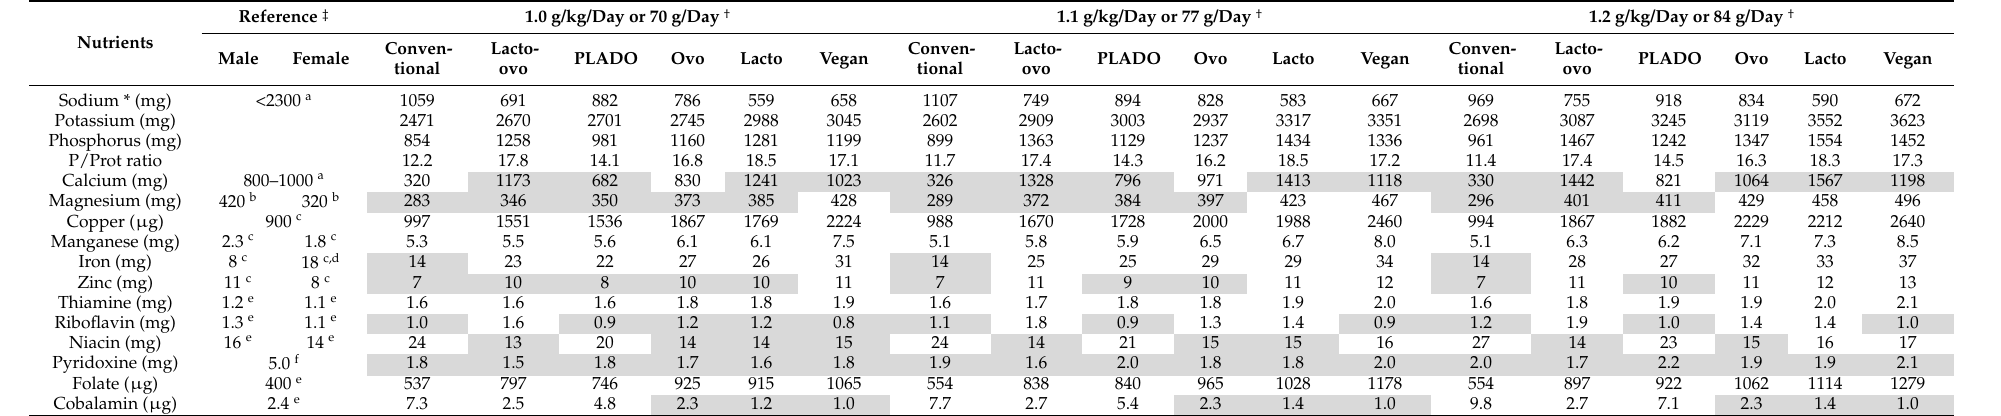
Abbreviations: P/Prot, phosphorus/protein; PLADO, plant-dominant. Note: Table cells with grey shading indicate values below or exceeding the reference value. * Only sodium naturally found in food without condiments added during cooking, table salt, or sauces. † Represents dietary nutrient content for a 70 kg person. ‡ The reference value refers to the CKD-specific recommendation for dietary sodium, calcium [3], and pyridoxine [30]; Recommended Dietary Allowance for magnesium, copper, iron, zinc, thiamine, riboflavin, niacin, folate, and cobalamin [27–29] and Adequate Intake for manganese [29]. a KDOQI Clinical Practice Guideline for Nutrition in CKD: 2020 Update [3]. b Dietary Reference Intakes for Calcium, Phosphorus, Magnesium, Vitamin D, and Fluoride (1997) [27]. c Dietary Reference Intakes for Vitamin A, Vitamin K, Arsenic, Boron, Chromium, Copper, Iodine, Iron, Manganese, Molybdenum, Nickel, Silicon, Vanadium, and Zinc (2000) [29]. d RDA for women 19–50 years old only. The RDA for women >50 years old is 8 mg/day [28]. e Dietary Reference Intakes for Thiamin, Riboflavin, Niacin, Vitamin B6, Folate, Vitamin B12, Pantothenic Acid, Biotin, and Choline (1998) [28]. f Kopple et al. 1981